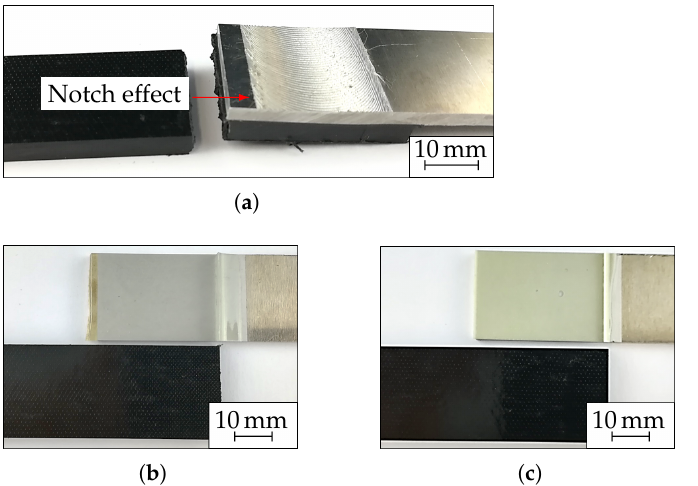
Figure 6. Comparison of the surfaces at fracture of PA6-GF30 and EN AW-6082-T6 joined with: FPJ (II-PSa) ( a ); epoxy-based adhesive ( b ); and polyurethane-based adhesive ( c ).